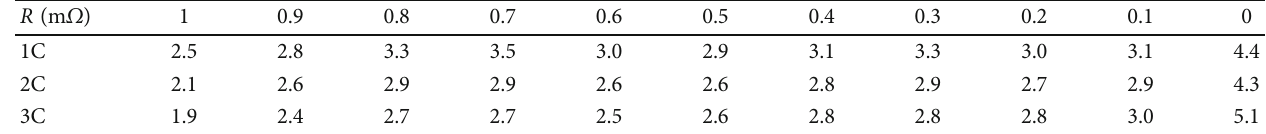
Table 4: The total internal resistance of each SOC of the battery when discharged at di ff erent rates at 25 ° C. R (m Ω )